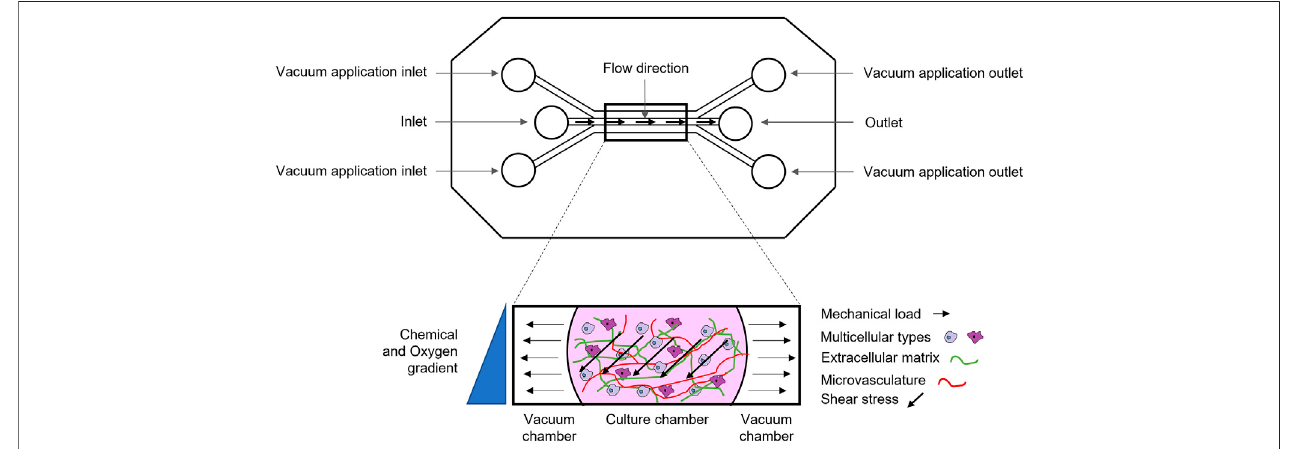
TABLE 1 | Summary of pros and cons of perfusion devices at the macro, milli, and micro scale. Pros Cons Macro Model bone porous microarchitecture scale Simulate mechanical properties of bone tissue (cid:129) low supply of nutrients and oxygen to cells in the centre of the scaffolds Presence of convective fl ow to ensure the mixing of culture medium (cid:129) necrotic area at the core of the construct aroundthe3Dcellularized scaffoldsallowing forbetternutrient/oxygen (cid:129) uneven distribution of fl uid shear stress, resulting in impaired transport than static cultures mineralization in the inner part of the scaffolds Fail to model paracrine communication, cell-cell interaction, cell-ECM interaction at the microscale level Milli scale Model bone porous microarchitecture Simulate mechanical properties of bone tissue Medium perfusion through the scaffold Accurately mimic the effect of interstitial fl uid fl ow Wide range of mechanical loadings to be applied Possibility to model